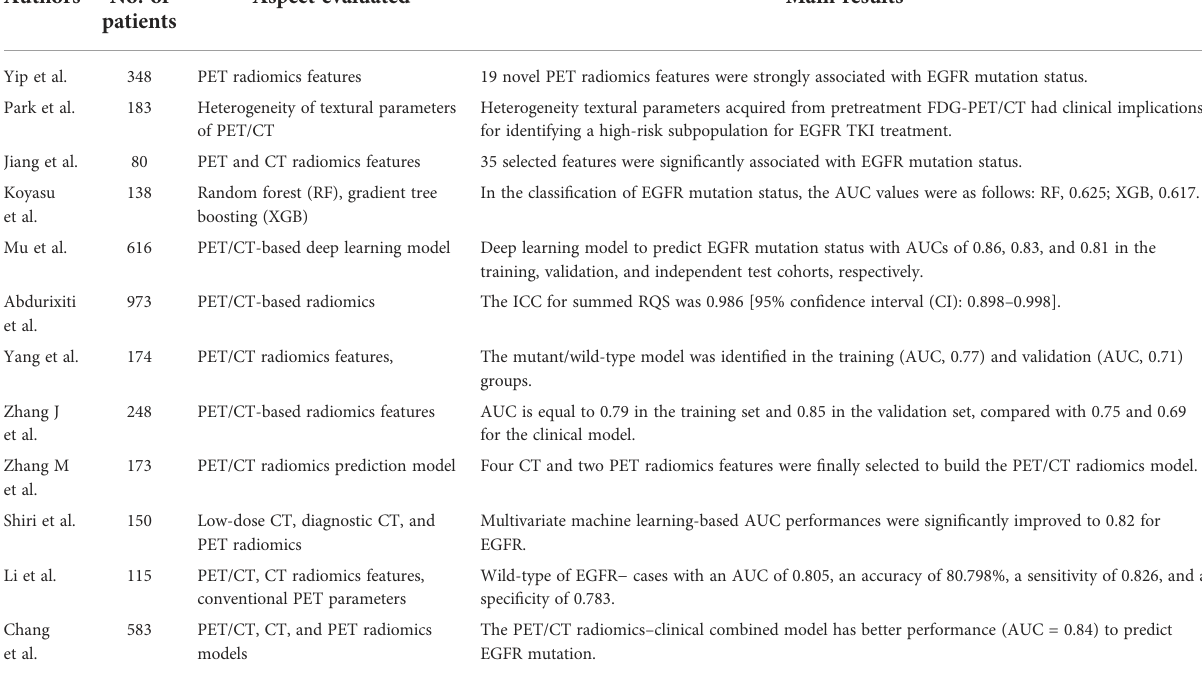
TABLE 2 Recent publications about the predictive value of 18 F-FDG PET/CT-derived radiomics with epidermal growth factor receptor mutation status in non-small cell lung cancer.